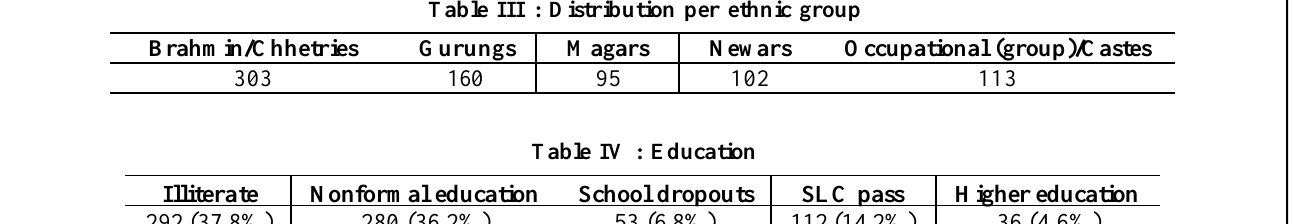
Table III : Distribution per ethnic